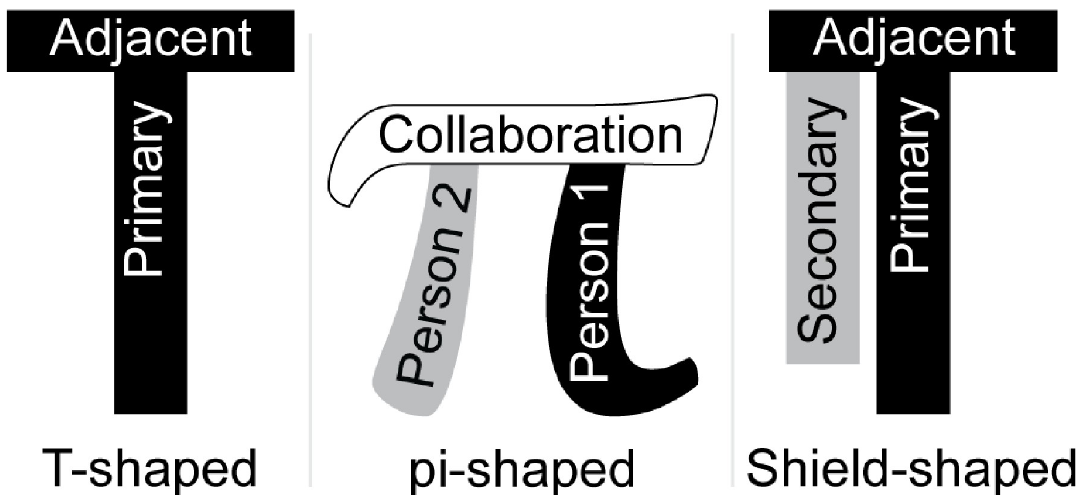
Fig 2. Models of interdisciplinary graduate education adapted from Pennington et al. [19]. Note . Adjacent, primary, and secondary refer to disciplines (e.g., primary discipline).